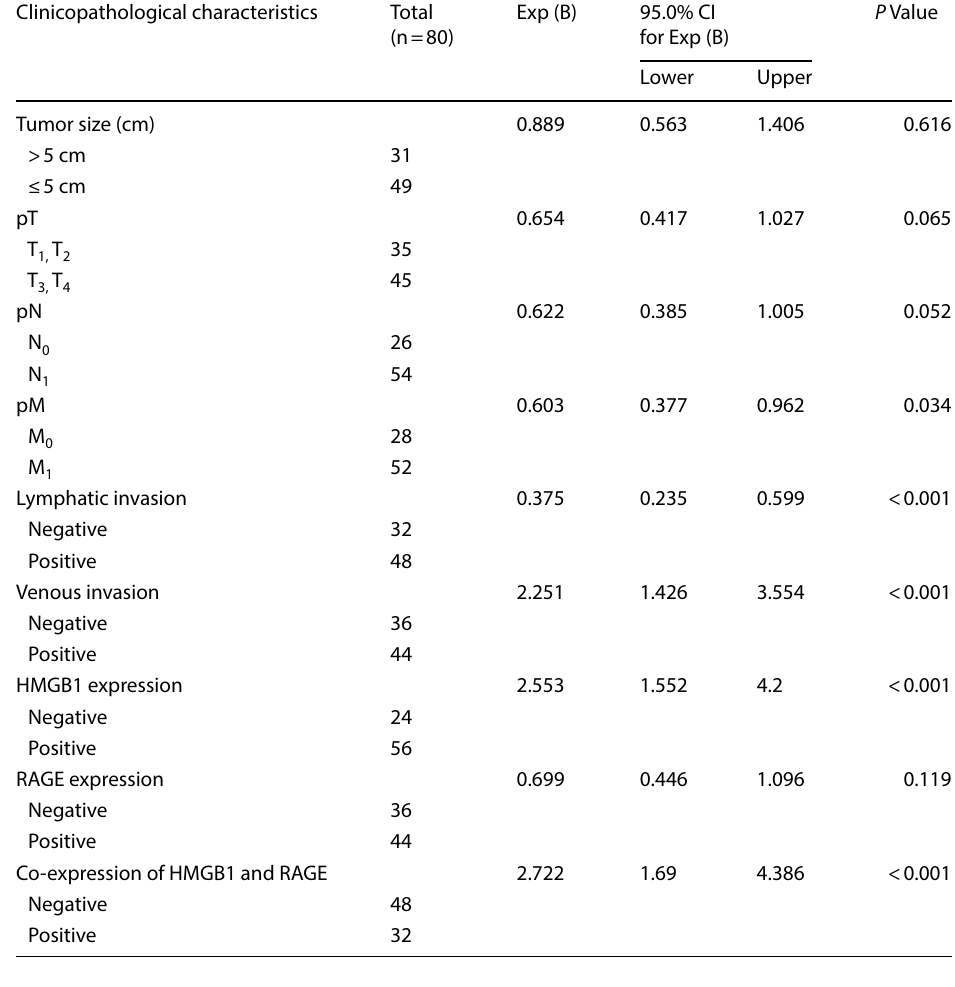
Clinicopathological characteristics